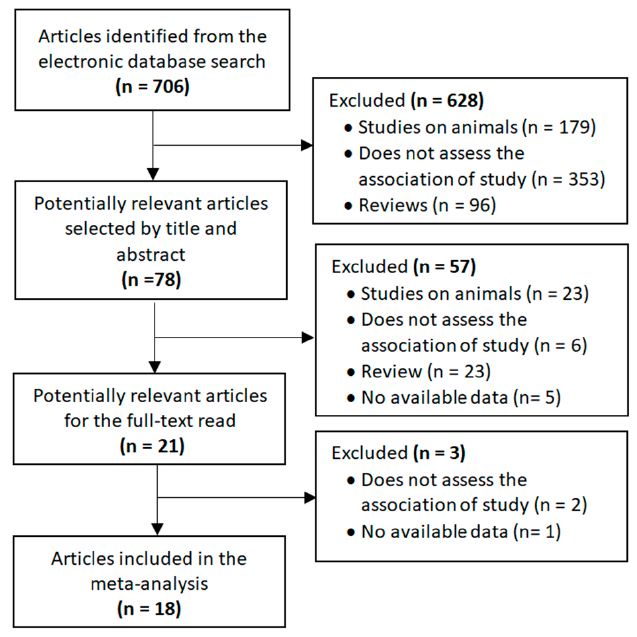
Figure 1. Flow diagram of selected studies.